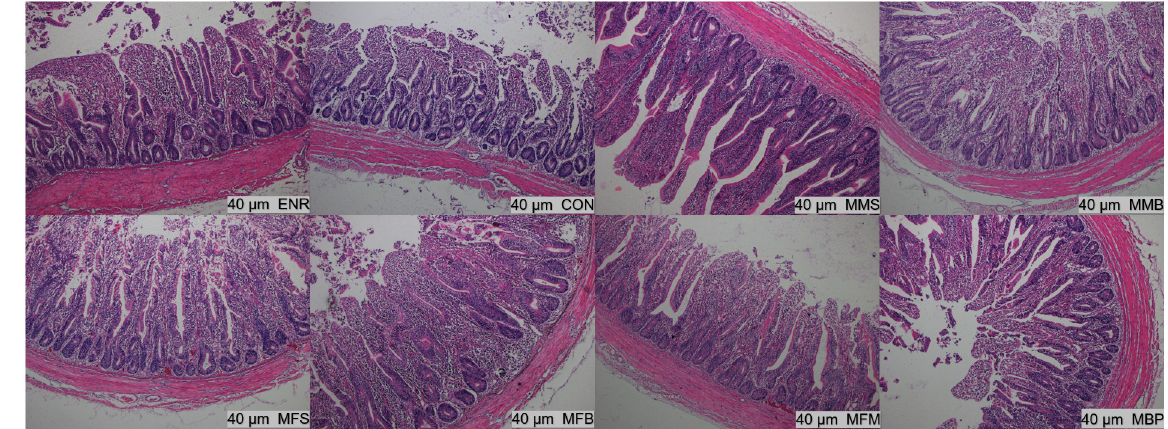
Fig 2. Histological structure of Hematoxylin and Eosin (H&E) staining ileum at 21 day of age. CON, control diet; ENR; CON + 100 mg/kg ENR, MMS; CON + 2000 mg/kg MOS + 300 mg/kg MAN + 1500 mg/kg SB, MMB; CON + 2000 mg/kg MOS + 300 mg/kg MAN + 500 mg/kg BS, MFS; CON + 2000 mg/kg MOS + 9000 mg/kg FOS + 1500 mg/kg SB, MFB; CON + 2000 mg/kg MOS + 9000 mg/kg FOS + 500 mg/kg BS, MFM; CON + 2000 mg/kg MOS + 9000 mg/kg FOS + 300 mg/kg MAN, MBP; CON + 2000 mg/kg MOS + 500 mg/kg BS + 37 mg/kg PT. SB; Sodium butyrate, FOS; Fructose oligosaccharide, PT; Phytase, BS; Bacillus subtilis, MOS; Mannose oligosaccharide, MAN; Mannanase.